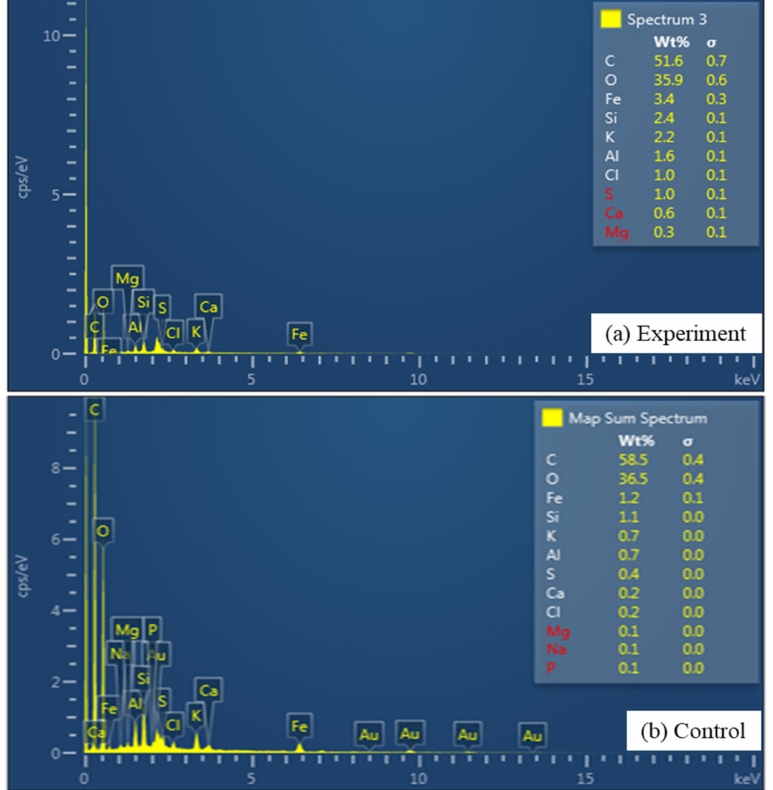
Figure 11. ( a , b ) EDS of Vetiveria zizanioides roots from AMD-treated ( a ) and control wetland ( b